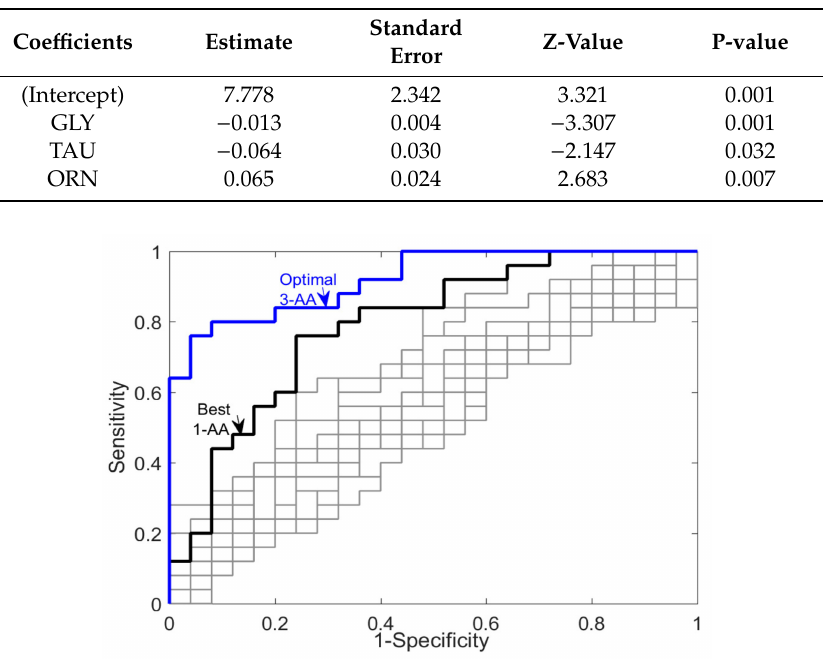
Figure 5. The ROC curves for the optimal multivariate amino acid regression biomarker and all seventeen amino acids as univariate biomarkers. Table 3. The results of the ROC curve analysis using the optimal 3-AA regression model and each of the univariate AA